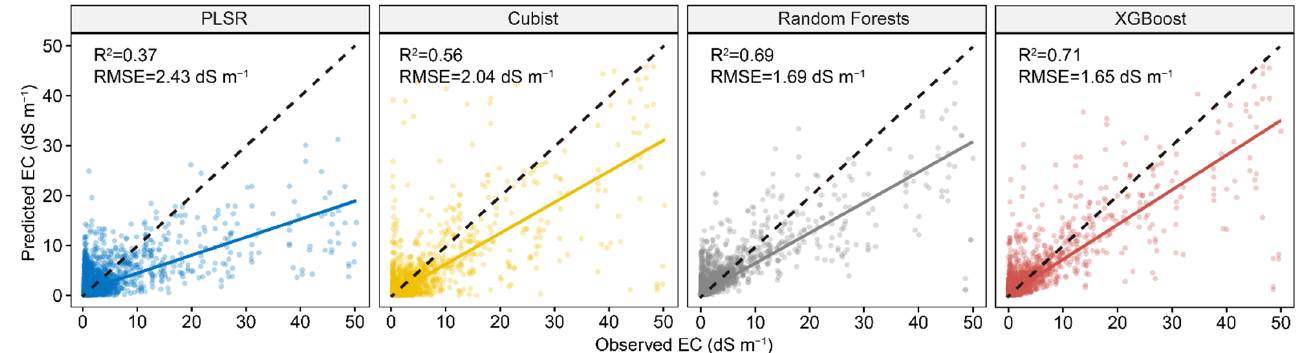
Figure 5. Scatter plots of four spectral predictive models using first 30 PCs of Vis-NIR spectra and environmental covariates. The solid line is a fitted line for each model, whereas the dashed line is the 1:1 line.